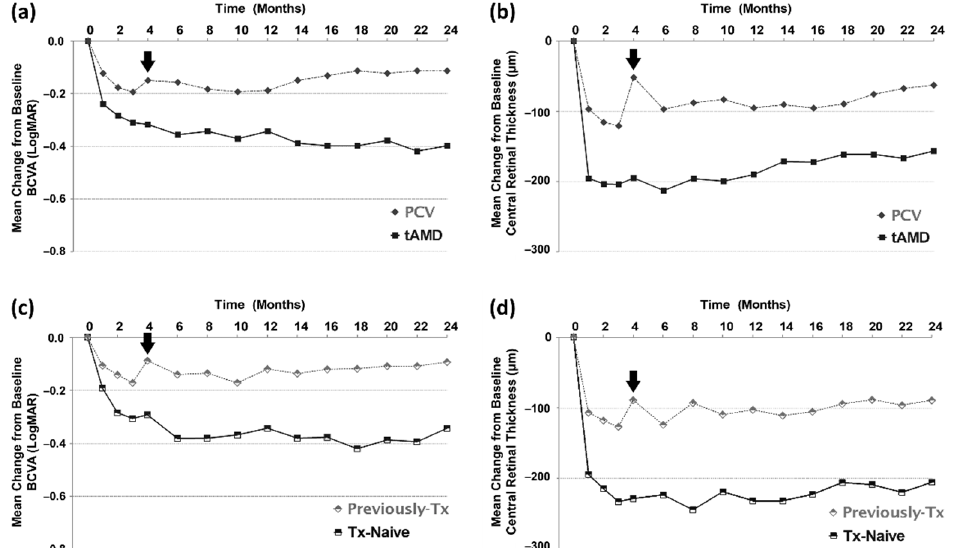
Figure 4. Subgroup analyses according to the subtypes of AMD and previous treatments. The eyes with PCV ( a , b ) and previously treated eyes ( c , d ) show less response to the three initial loading doses, and show much worsening when the injection interval is increased at the fourth month (ar- rows).